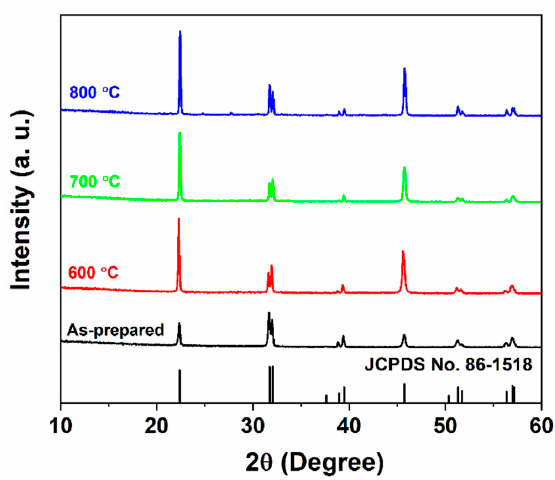
Figure 1. Powder XRD patterns of as-prepared BiFeO 3 microspheres and sintered at 600, 700, and 800 ° C.